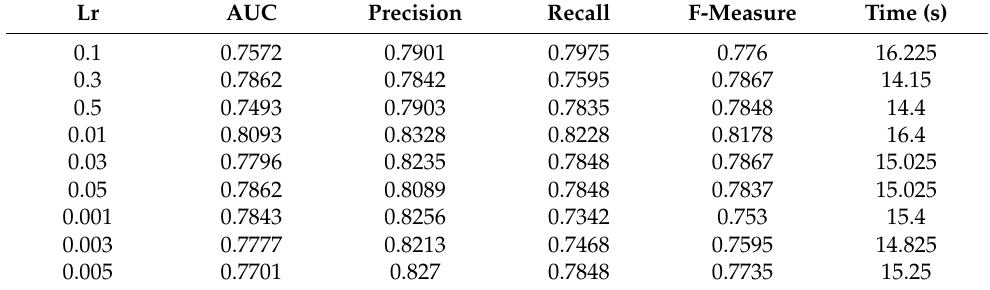
Table 4. Learning rate effect.